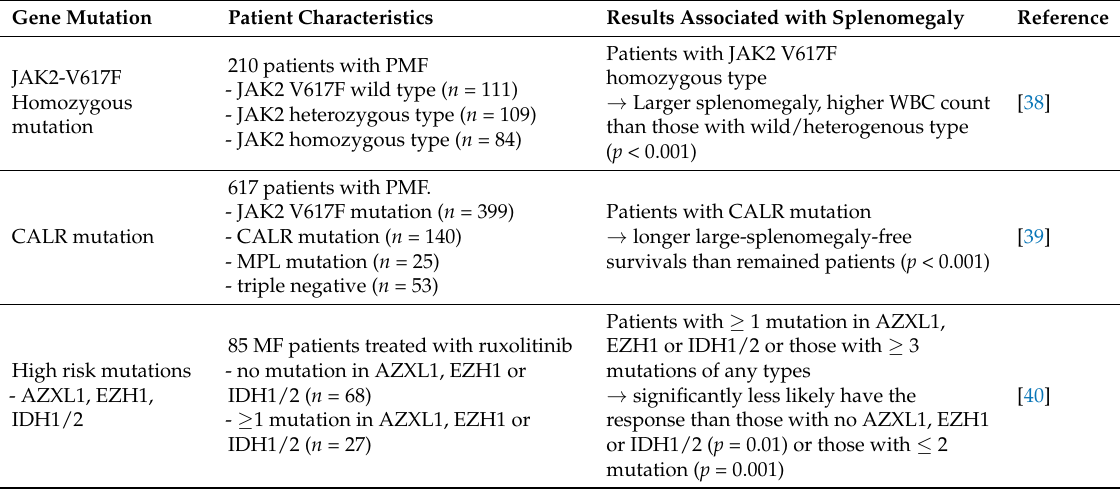
Table 1. Gene mutations with splenomgaly in patients with Myelofibrosis (MF). Gene Mutation Patient Characteristics Results Associated with